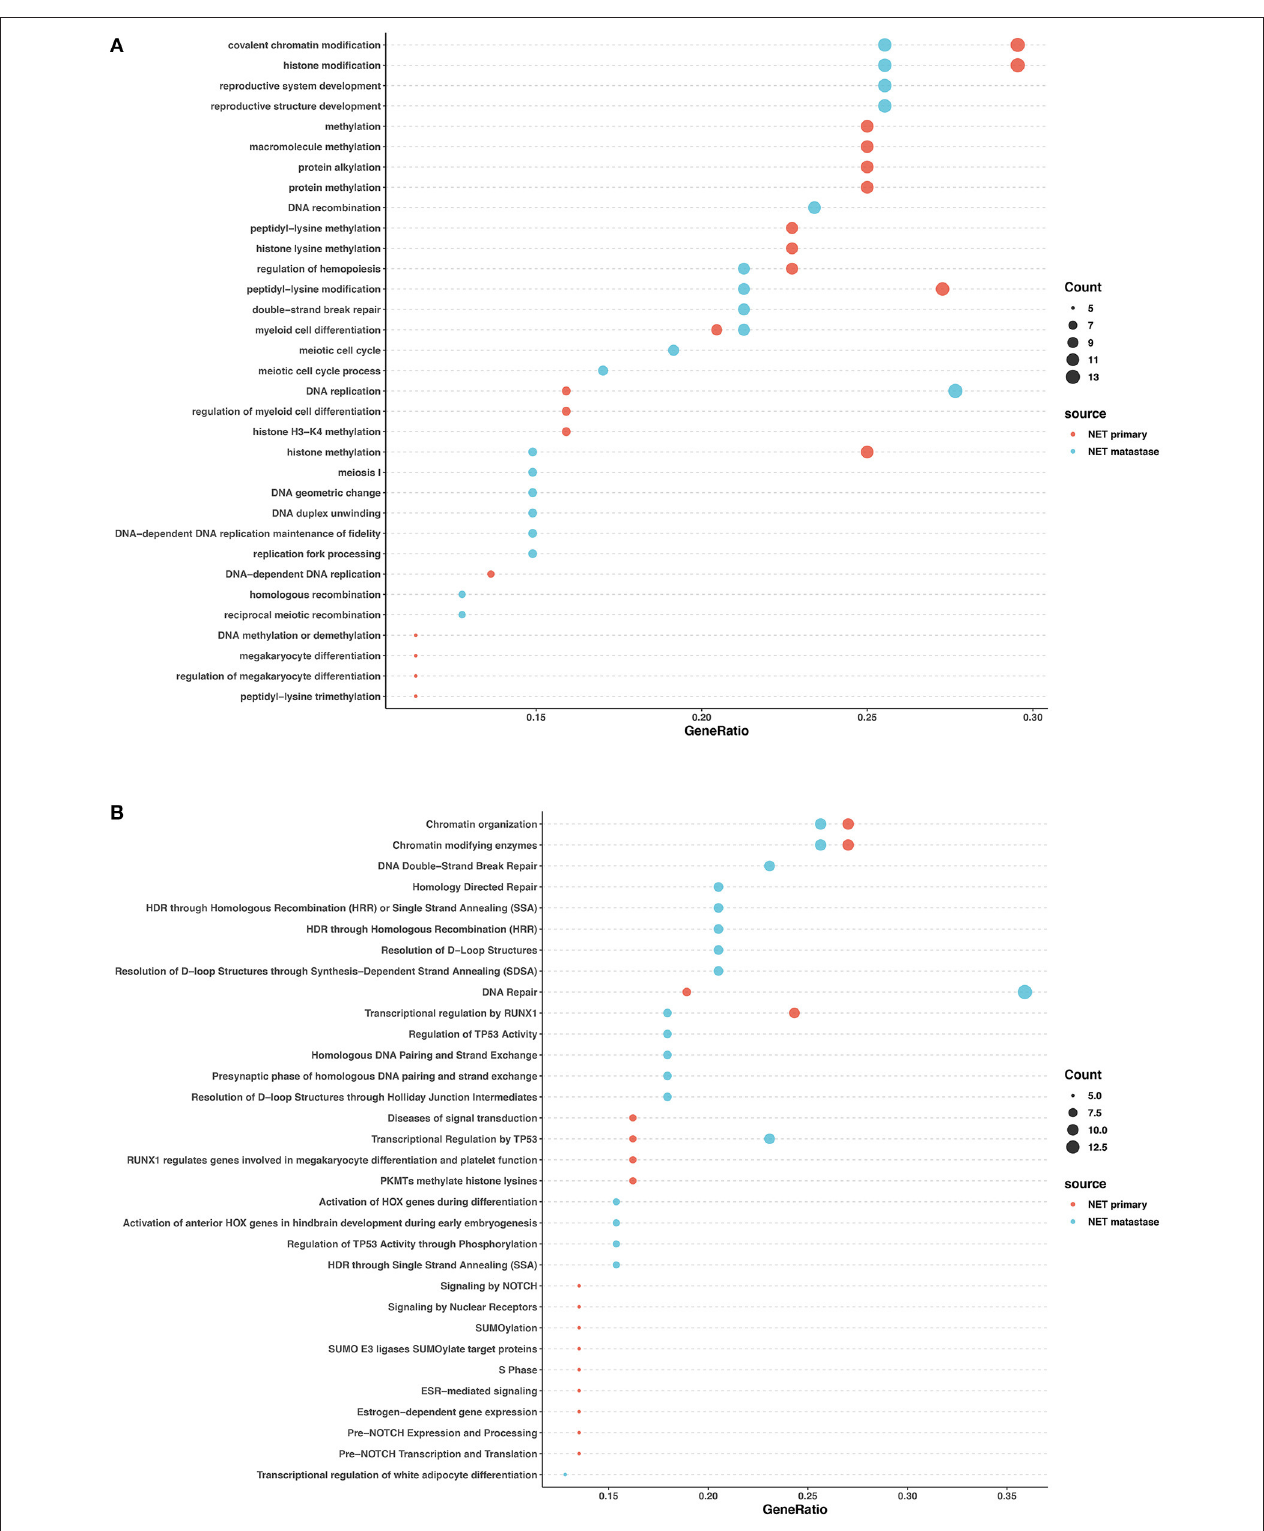
FIGURE 4 | GO and pathway enrichment analysis of mutated genes involved in G2 NETs. GO enrichment analysis of biological process in mutated genes in NETs (A) . Reactome pathway enrichment analysis in NETs (B) . Dot size corresponds to number of genes; gene ratio is defined as percentage of genes in certain pathways compared with all genes in the